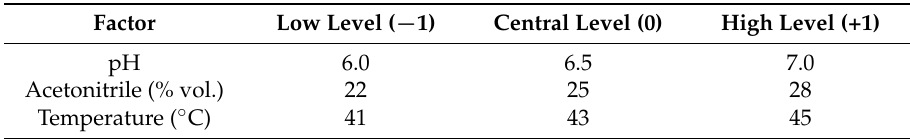
Table 1. Nominal values corresponding to low, central and high